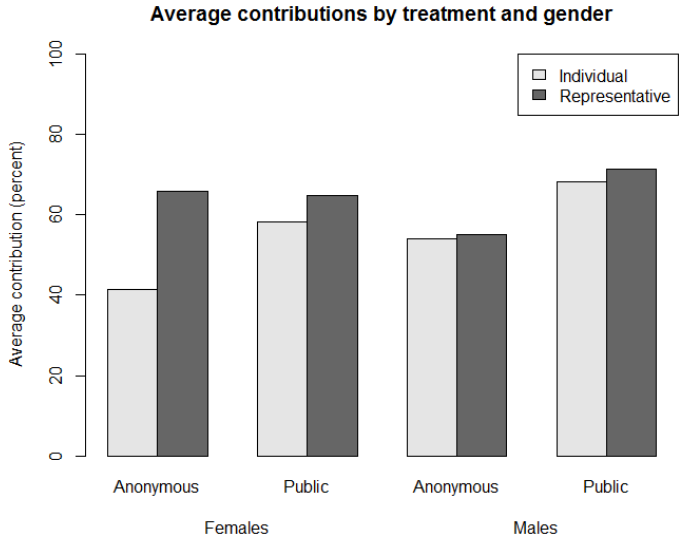
Figure 2. Average contributions (in percent of endowment) by treatment and